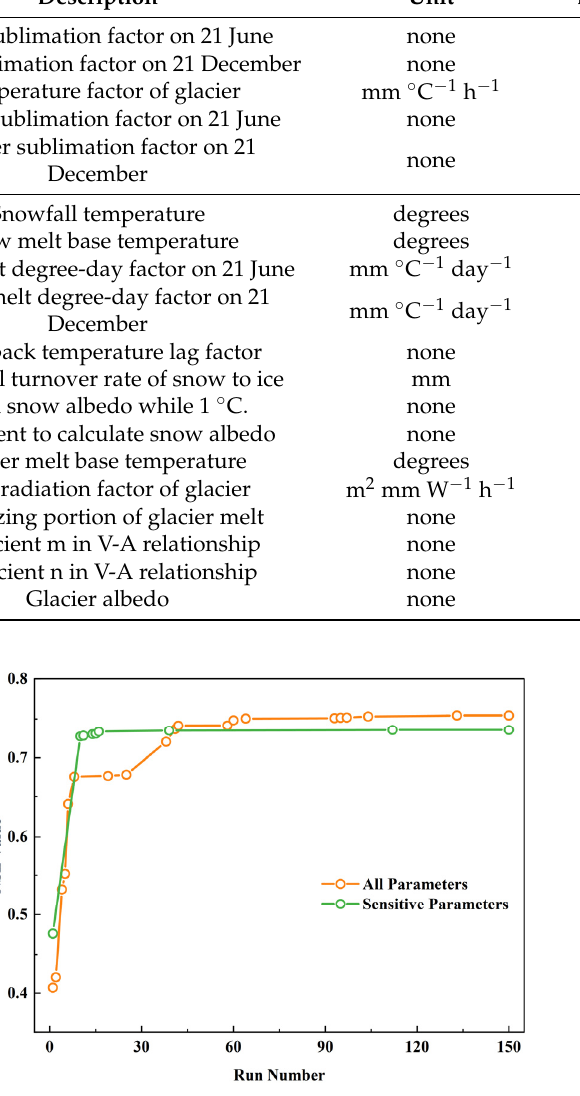
Figure 4. NSE value change during the first 150 calibration runs, the red solid line indicates the value change calibrated with all 25 parameters except for the glacier refreezing coefficient, while the green line describes the results computed with only the two most sensitive parameters using the Sobol